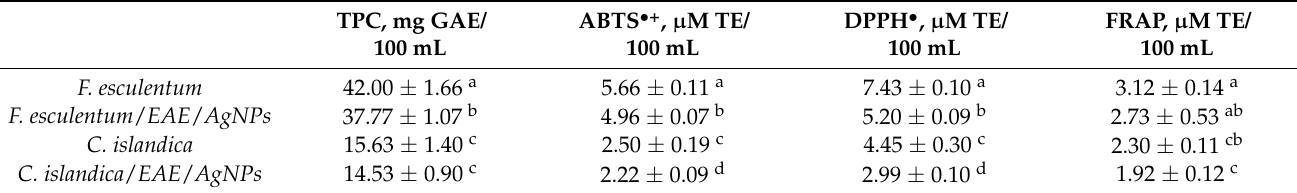
Table 2. Total phenolic content and in vitro antioxidant capacity of F. esculentum and C. islandica . TPC, mg GAE/ 100